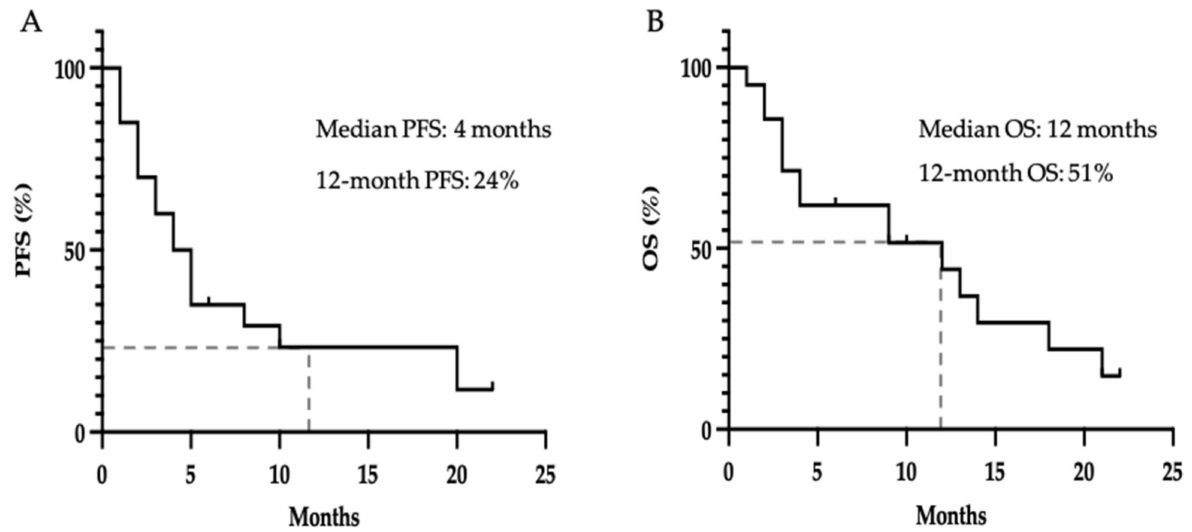
Figure 3. Kaplan–Meier estimate for ( A ) Progression free survival on lenvatinib, defined as time from first dose until objective disease progression; ( B ) Overall survival from initiation of lenvatinib, defined as time from first dose to death from any cause; dashes indicate censored